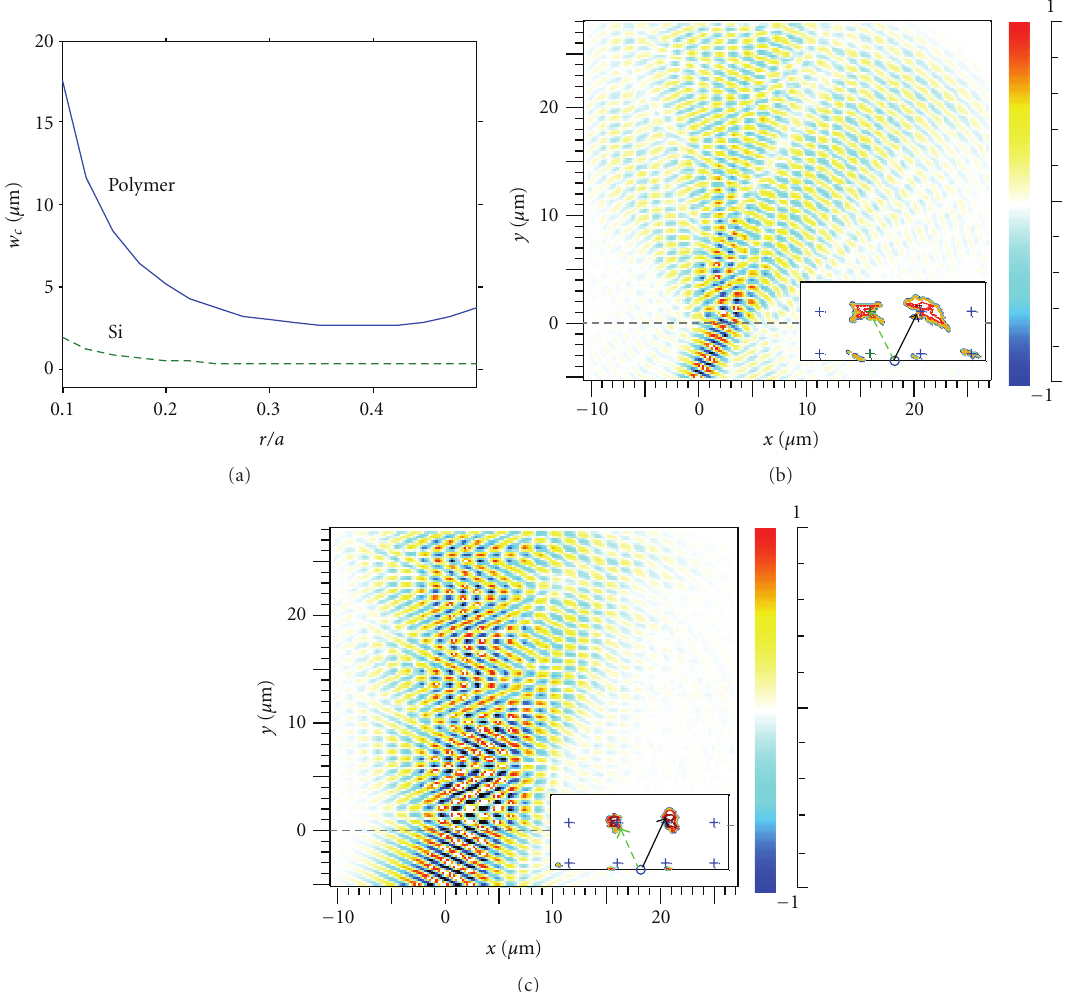
Figure 1: (a) w c versus r/a curve given by (3) for polymer-based and silicon-based metamaterials. (b) Beam propagation in a polymer metamaterial for a Gaussian beam with a width w = 3 μ m. The metamaterial region starts at 5 μ m from the bottom of the figure (the interface is indicated by a dashed line) and extends upwards. Inset: 2D Fourier transform of the spatial field in the photonic crystal. The wavevector k 0 and k g are indicated by a black arrow and a green dash arrow. The wavevector of various di ff raction orders (on a square lattice in the reciprocal space) are marked by crosses. (c) Same as in (b) except w = 10 μ m.